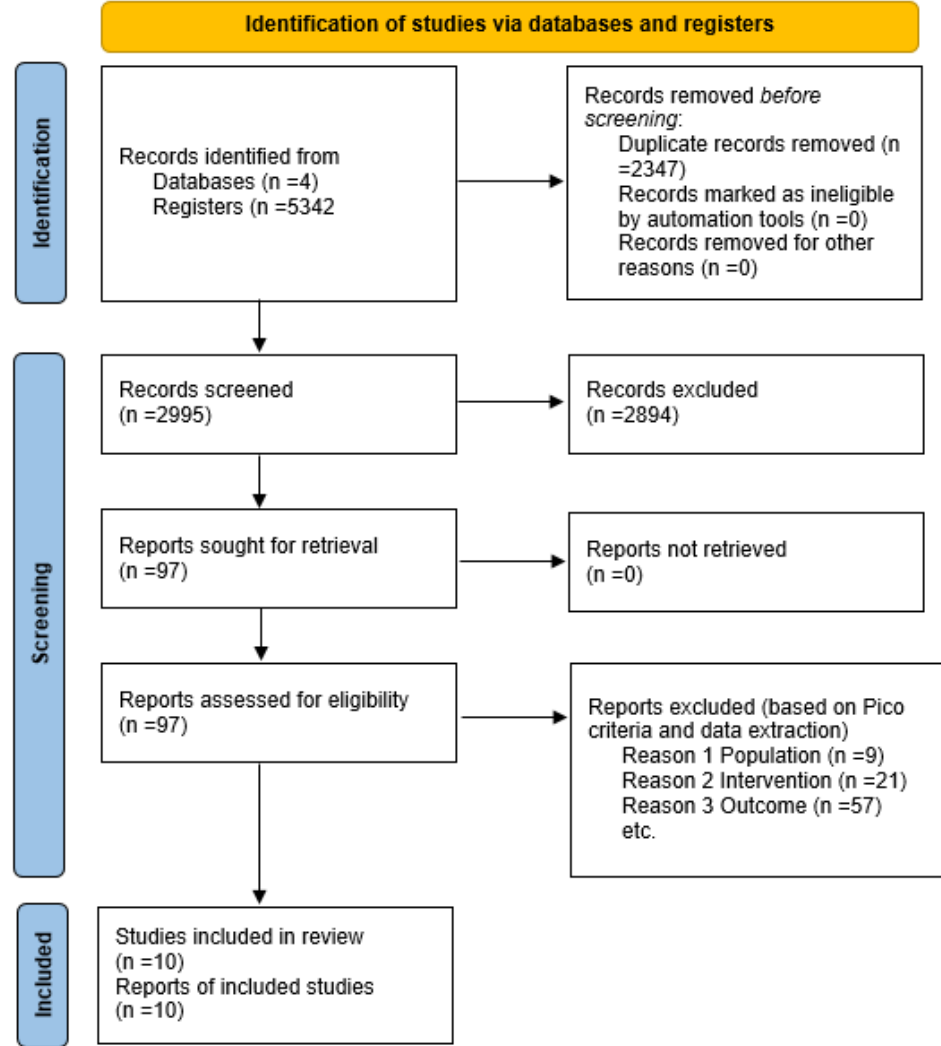
Figure 1. PRISMA 2020 Flow Chart of Selected Studies.